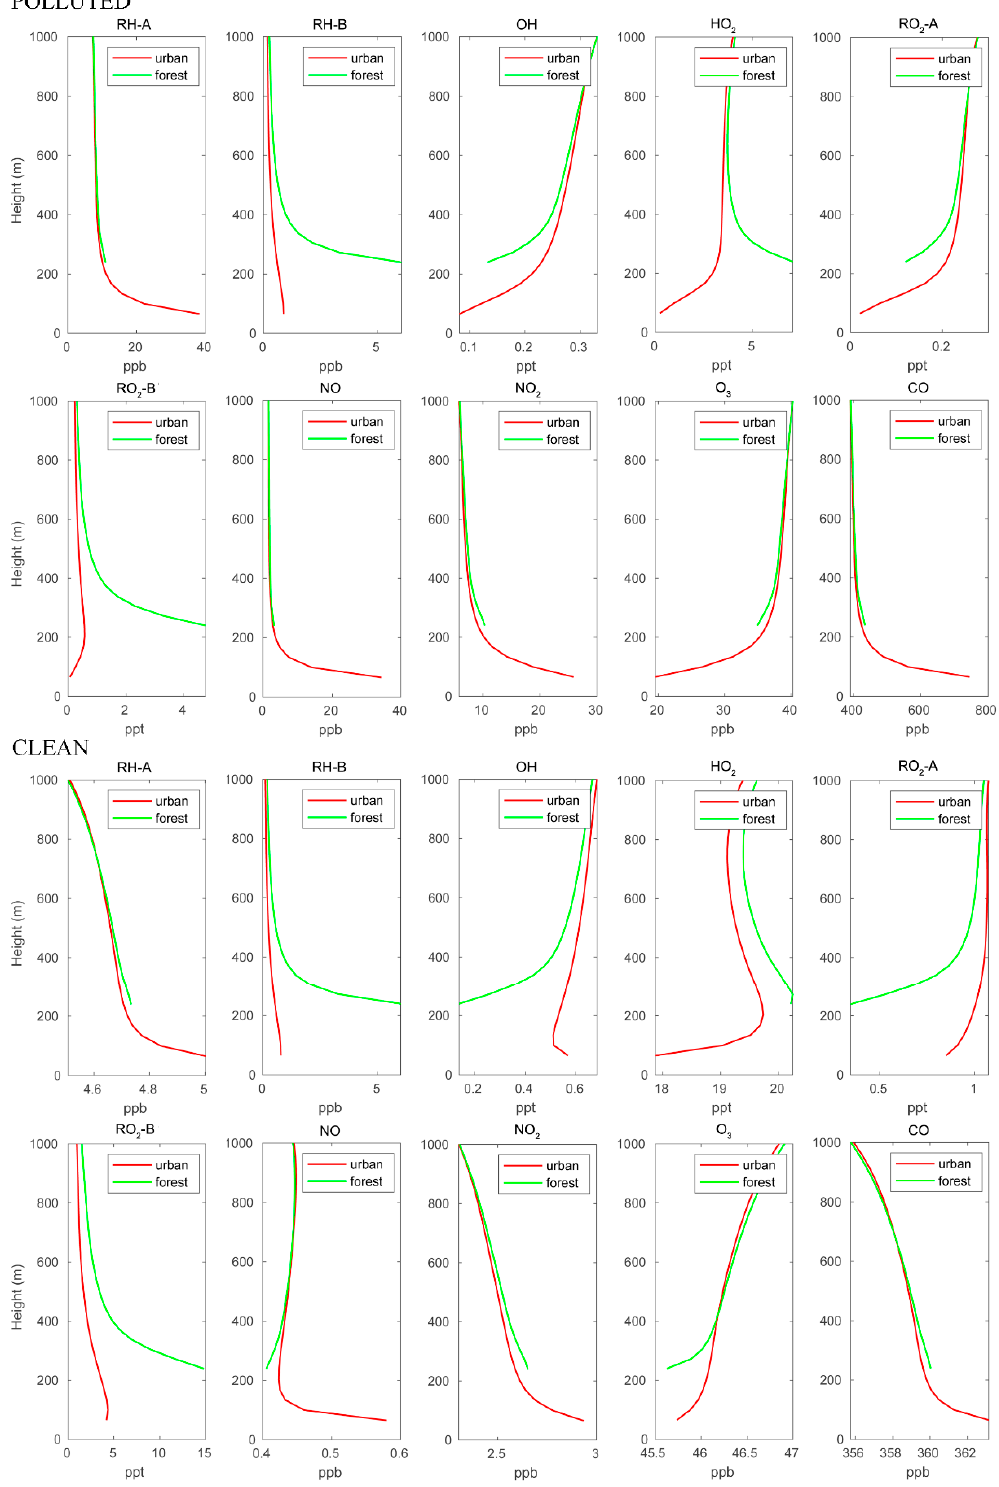
Figure 3. Vertical distribution of different chemical species calculated over the urban and forested areas for POLLUTED and CLEAN conditions.